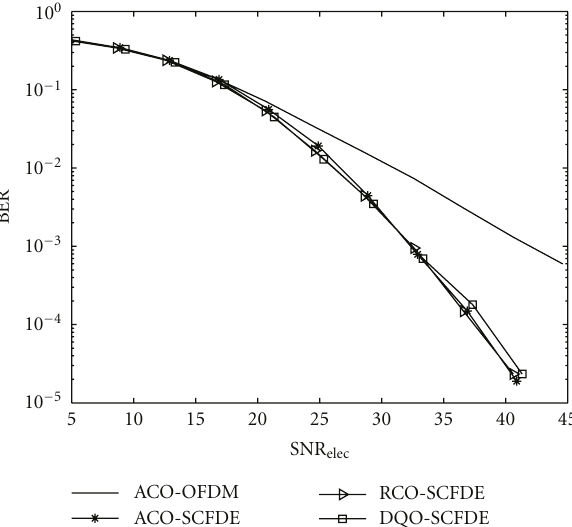
Figure 11: MMSE BER comparison of ACO-OFDM, ACO-SCFDE, RCO-SCFDE, and DQO-SCFDE with N = 64, QPSK input symbols with power 0.1 W and L =